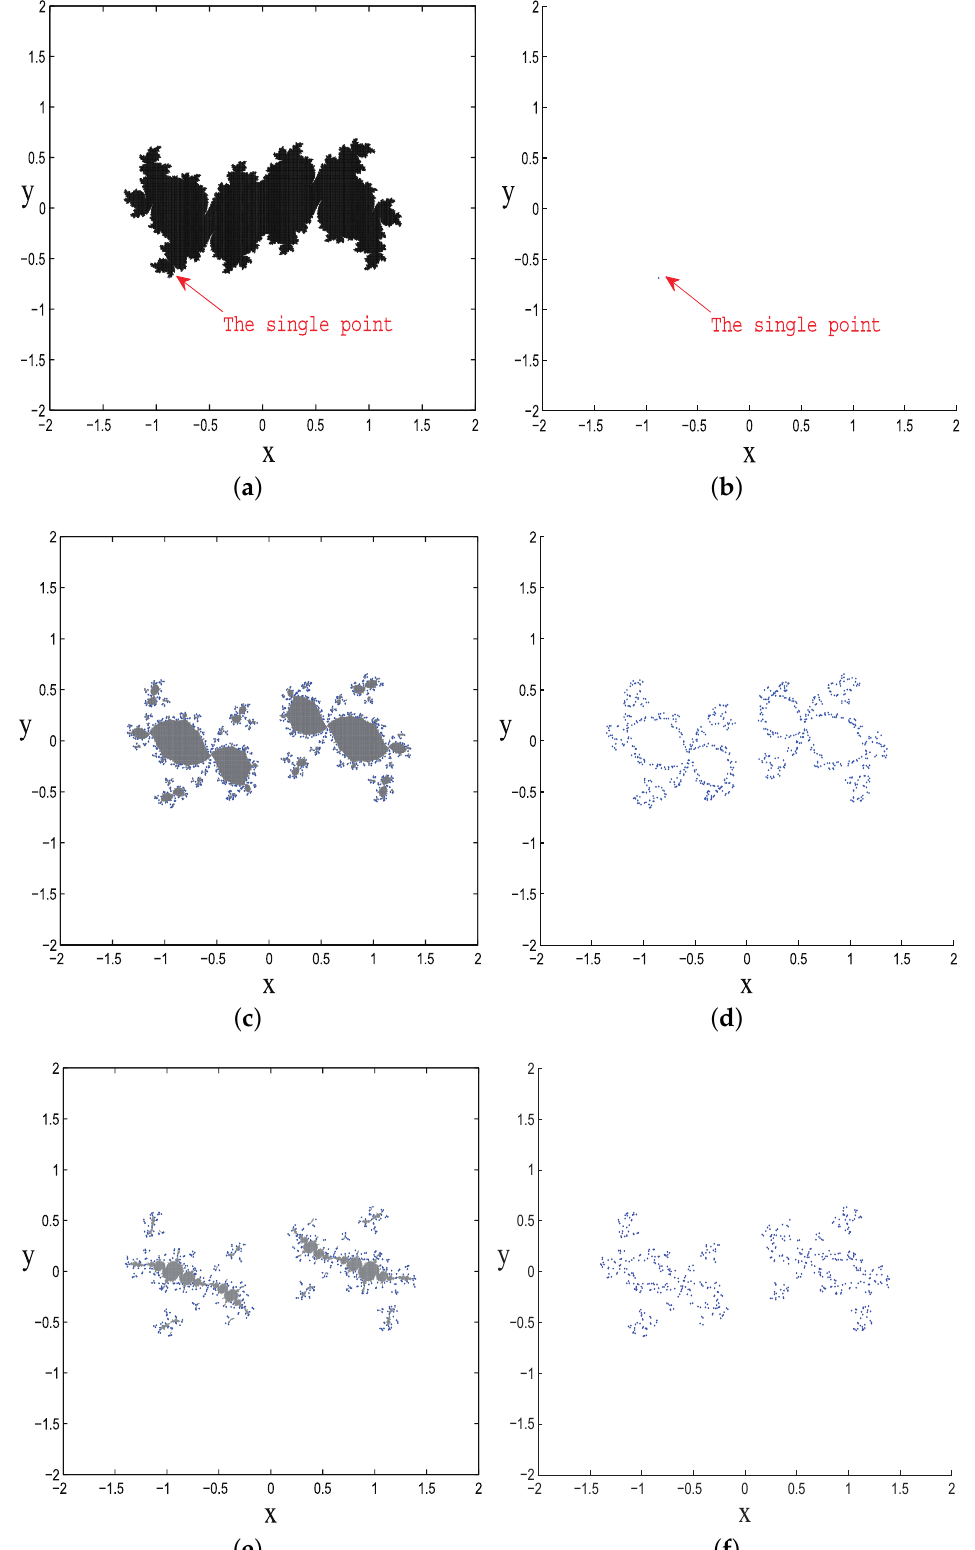
0.68, c 2 = 0.68, c 2 = − −